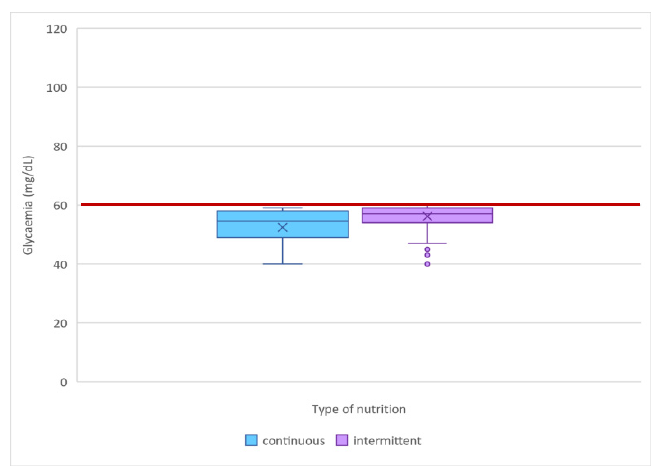
Figure 4. Median, minimum, and maximum hypoglycemic values for each group: in the continuous feeding group, the median was lower, and the amplitude of the wider range was higher. The red line indicates the reference value for euglycemia.